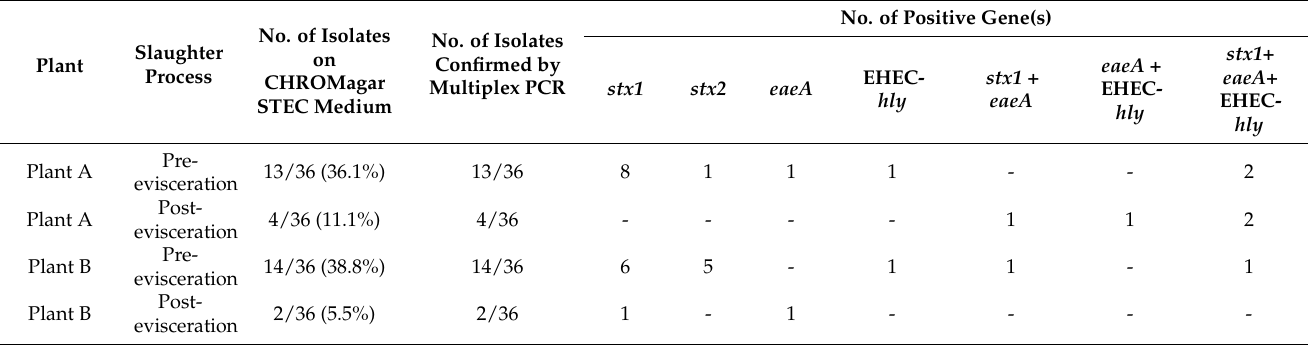
Table 3. The occurrence of presumptive non-O157 STEC strains in beef carcass samples during pre- and post-evisceration in two plants using CHROMagar STEC medium and multiplex